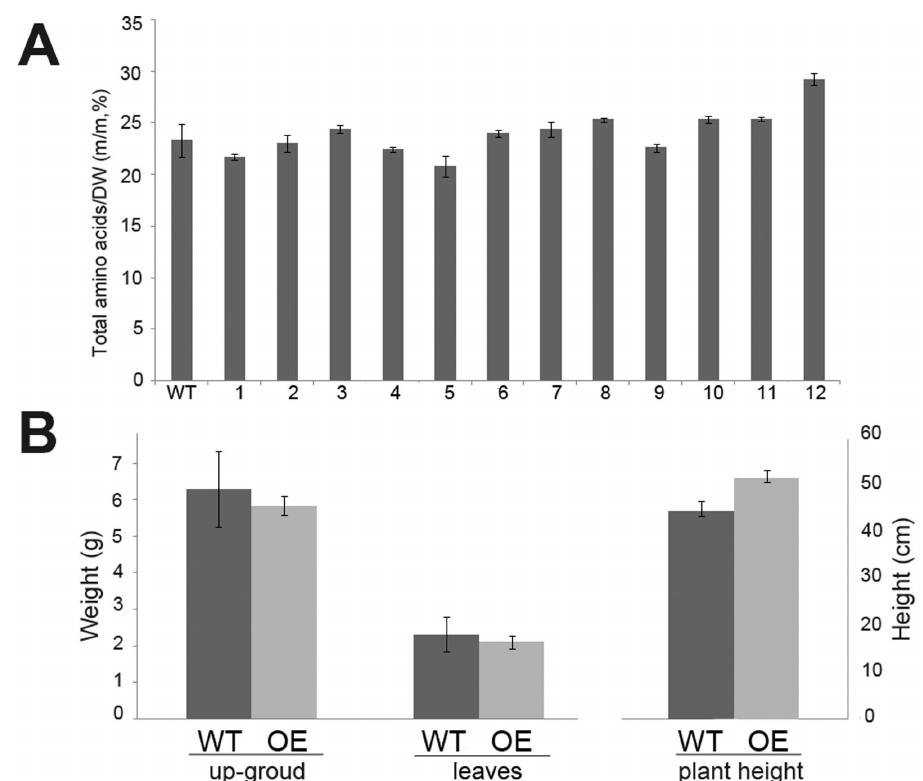
Figure 7. Analysis of total amino acids and forage products in wild-type and transgenic plants. A. Total amino acid content in leaves of transgenic and wild-type plants. m/m, % represented mass ratio of total amino acids from dry weight; WT: wild-type plant; 1–12: 12 lines of transgenic alfalfa plants; the bar represented 6 SE. B. Weight of up-ground part and leaves products and height of wild-type and transgenic plants. WT : wild- type plant; OE: the average number of 12 lines of transgenic alfalfa plants, the bar represented 6 SE.